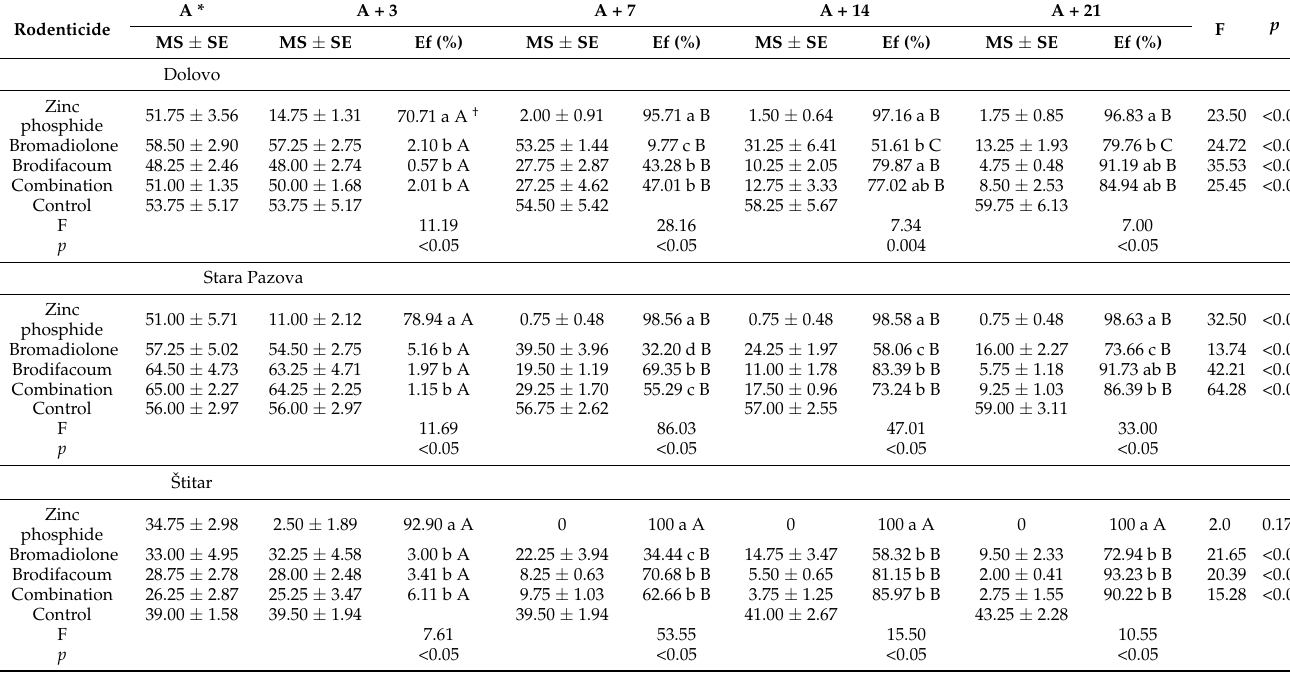
Table 3. Average number of active burrows of common vole in alfalfa crop and efficacy of rodenticides 3, 7, 14 and 21 days after the beginning of trial at Dolovo, Stara Pazova and Štitar (for all analysis, df: 3,